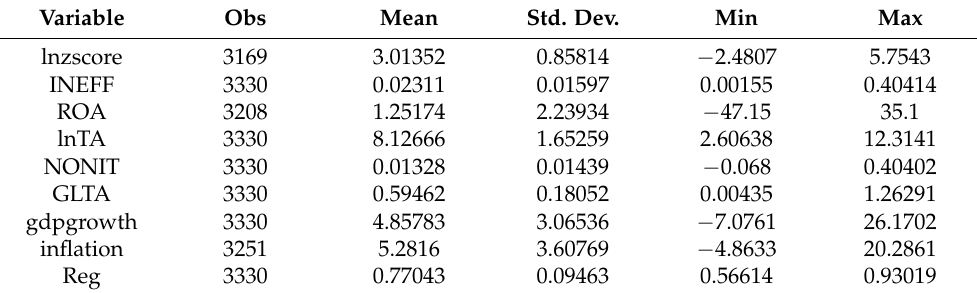
Table 1. Descriptive Statistics (Full Sample).